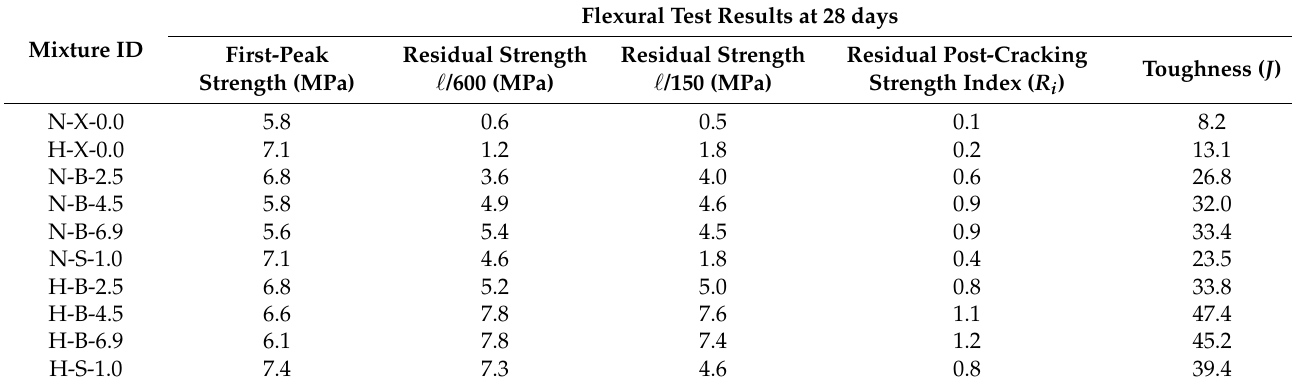
Table 7. Mechanical properties of the cementitious